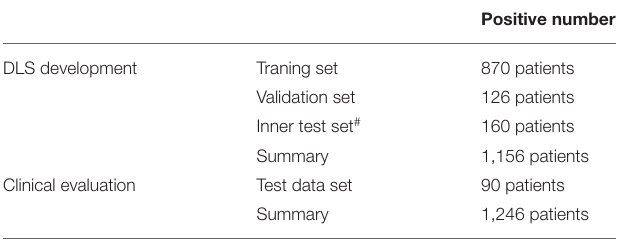
TABLE 1 | Data distribution in the manuscript.